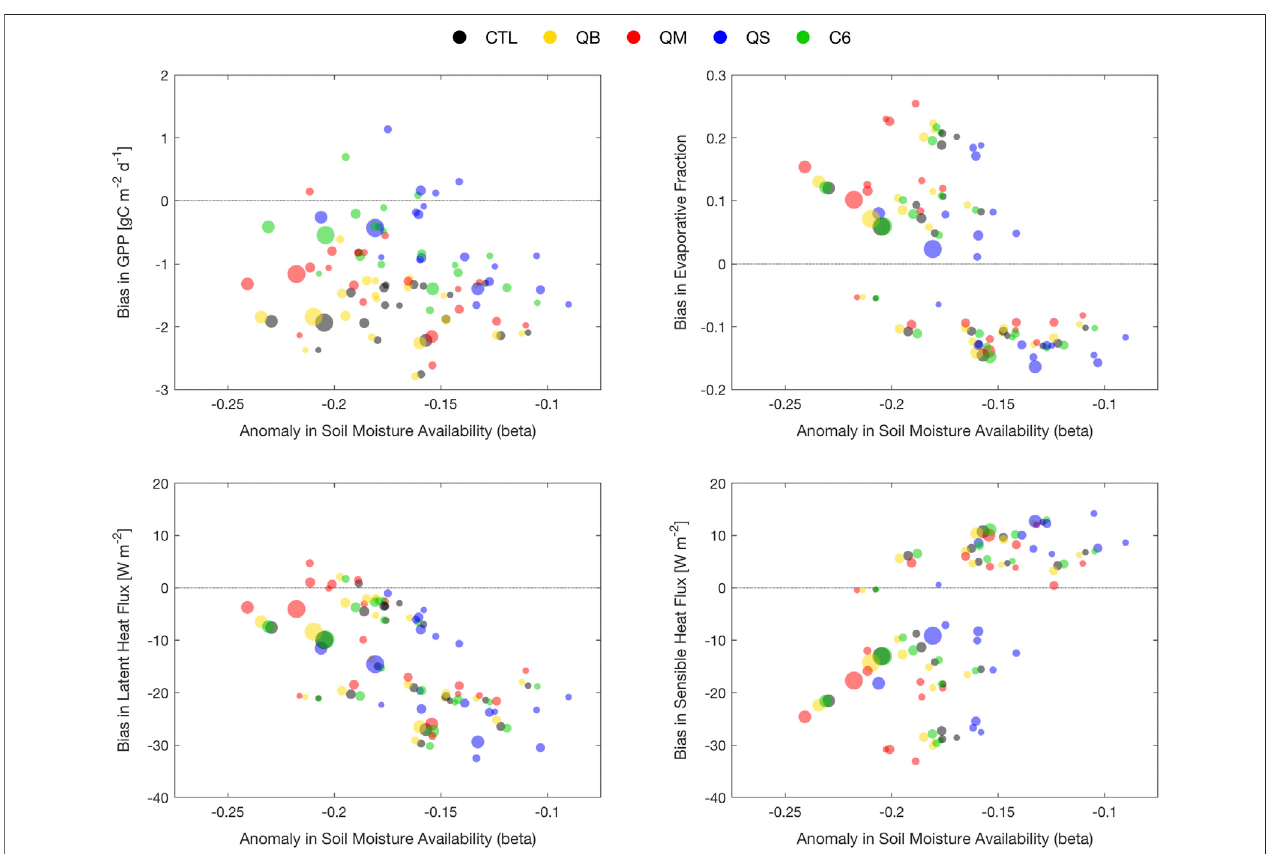
FIGURE8| ModelerrorsinGPP(topleft),evaporativefraction(topright),latentheat(bottomleft)andsensibleheat(bottomright)forthetoptendroughtsinEurope in the period 1979 – 2011 identi fi ed via the mask developed from Figure 7 .